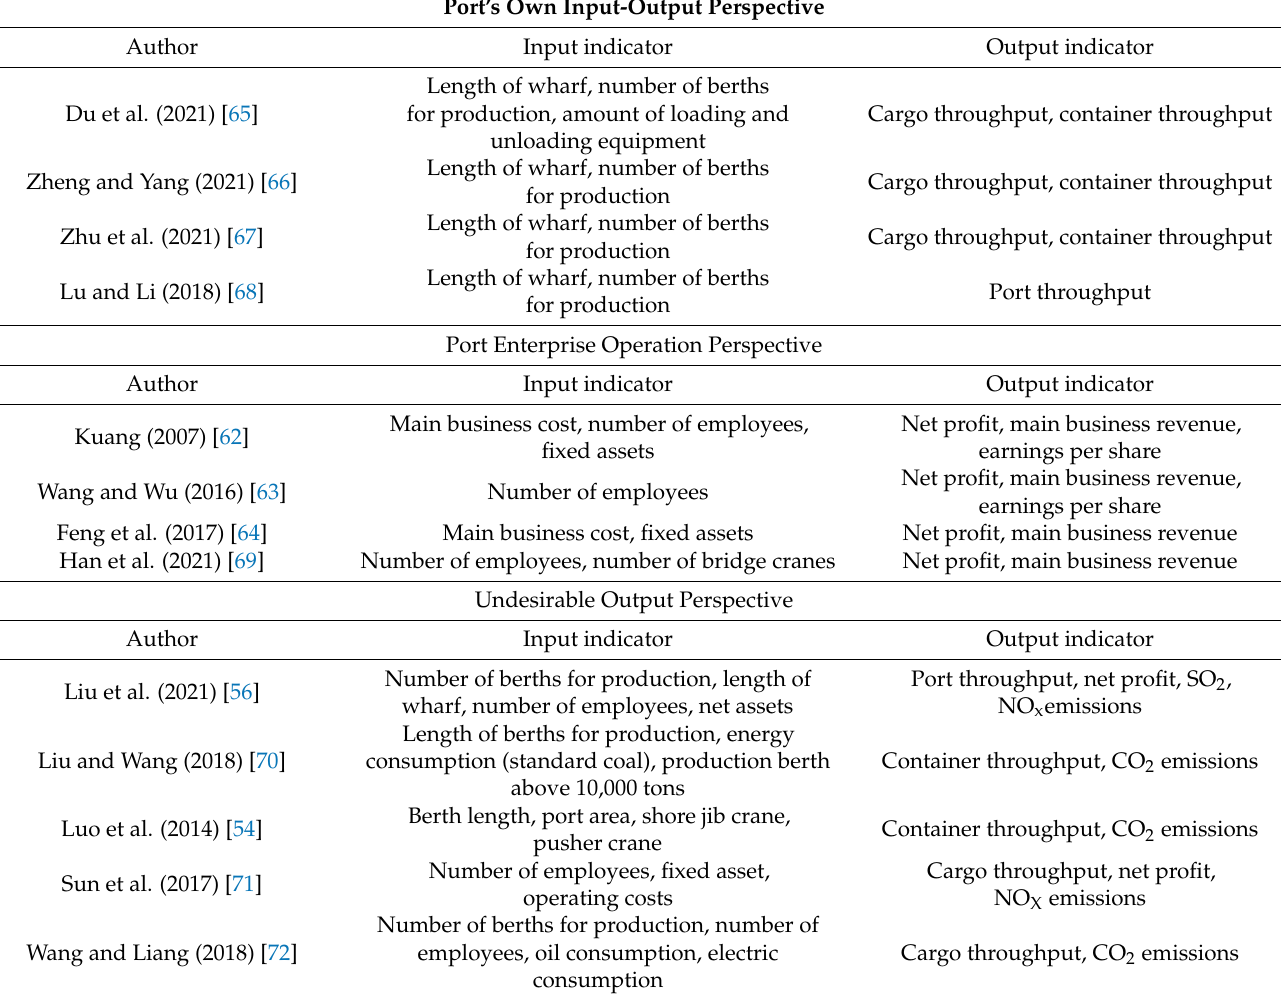
Table 1. Port input-output literature